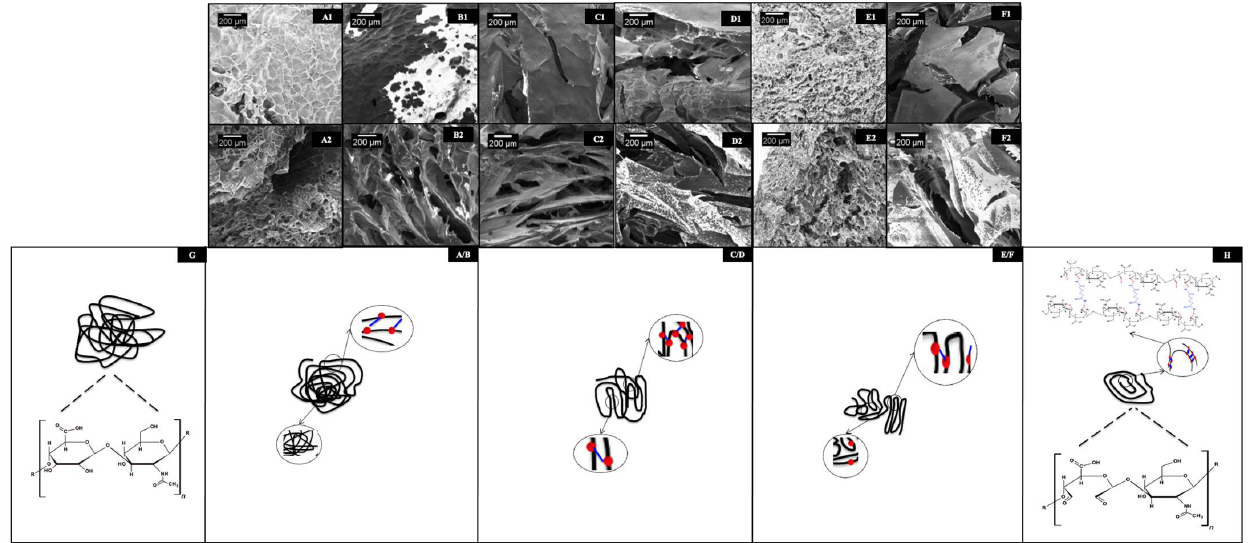
Figure 8. Oxi-HA hydrogel images: ( A , B ) oxi-HA 44% with 4% ADH and 8% ADH, ( C , D ) oxi-HA 65% with 4% ADH and 8% ADH, respectively, and ( E , F ) oxi-HA 82% with 4% ADH and 8% ADH, respectively. ( A–F1 ) Surface scanning electron microscopy images and ( A–F2 ) fracture scanning electron microscopy images. Structural changes from HA ( G ) to oxi- HA/ADH hydrogels ( H ) as a function of their oxidation degree and cross-linking reaction ( A / B , C / D , E / F ). (Reproduced with permission from Elsevier (França et al., 2019)).